Question: Based on the figure, does the quantity rise or fall?
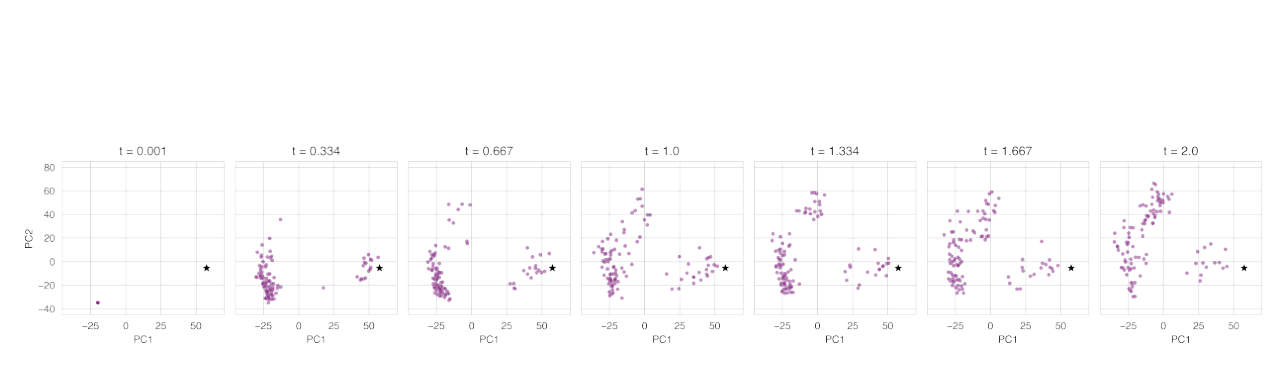
Answer: increasing